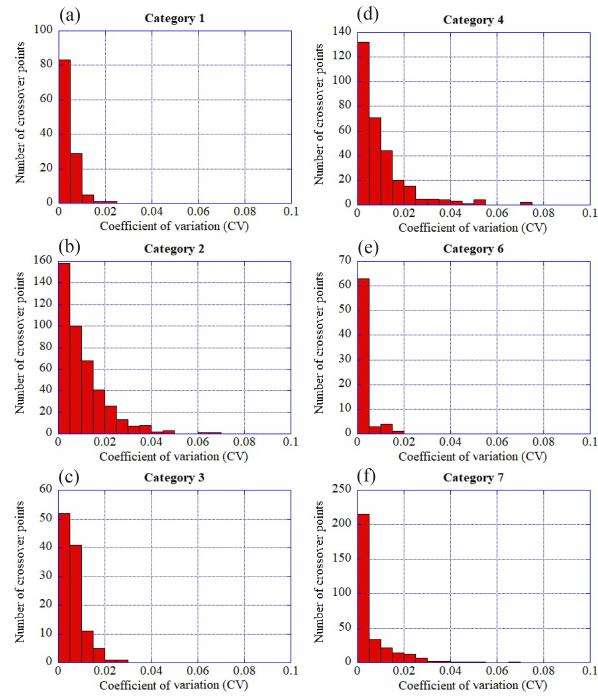
Figure 7. Histograms of the coefficient of variation (CV), a ratio of the standard deviations of the integrated values to a mean of the integrated value, within a 250km radius for nitrate in (a) category 1, (b) category 2, (c) category 3, (d) category 4, (e) category 6, and (f) category